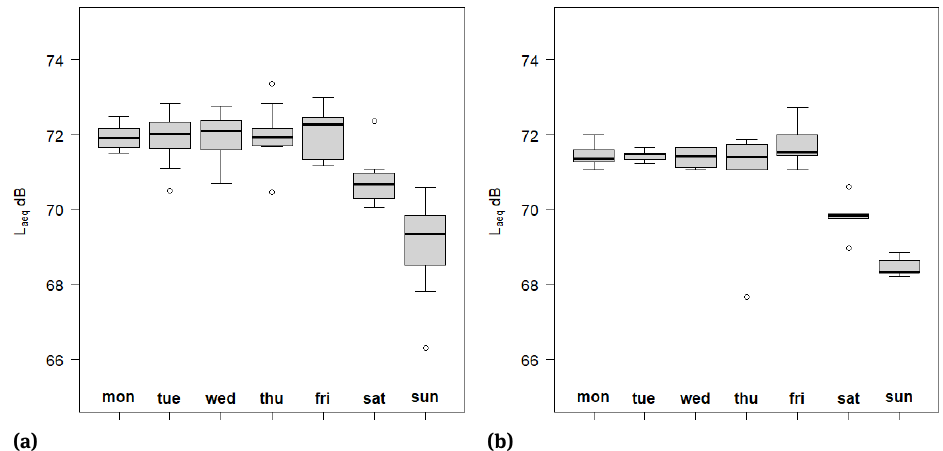
Figure 12: Box plots of L Aeq , T for each day (from 6.00 to18.00) of the week: a) in 2012, b) in